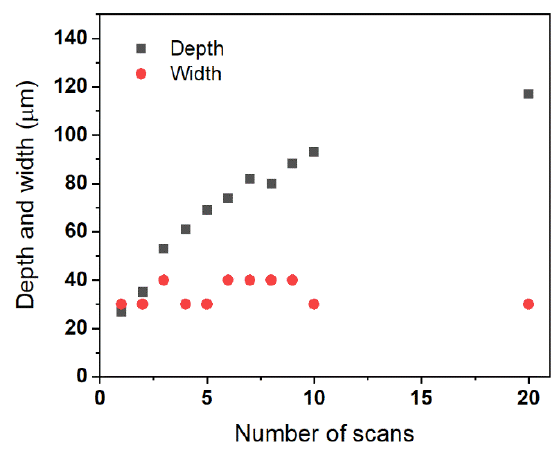
Figure 10. Depth and width of the groove as a function of the number of scans.